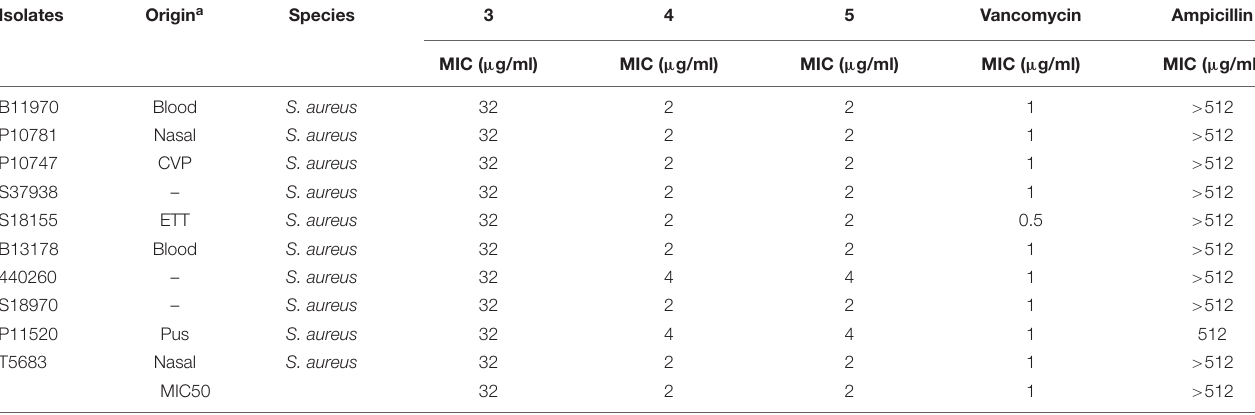
TABLE 2 | Minimum inhibitory concentration of Teixobactin derivatives against methicillin-resistant Staphylococcus aureus (MRSA). Isolates Origin a